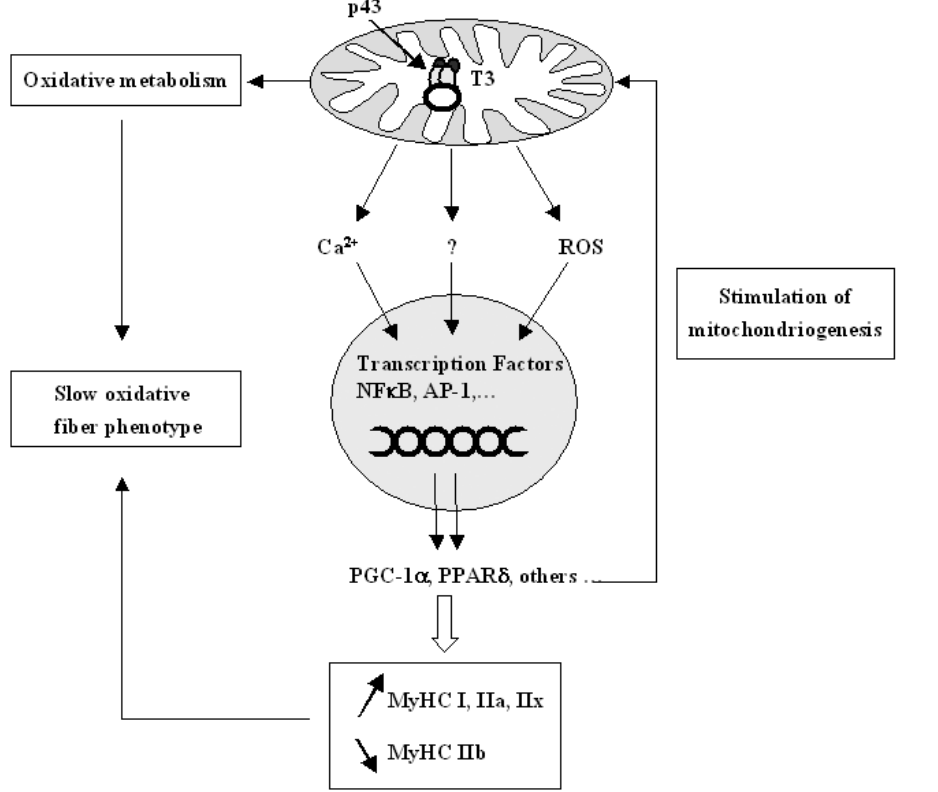
Figure 7. A positive regulatory loop between mitochondrial activity and nuclear genes such as PGC-1 a and PPAR d could be able to coordinate the increase in oxidative metabolism and the expression of slower myosin isoforms. A stimulation of mitochondrial activity induced by p43, could modulate Ca 2 + signalling and mitochondrial reactive oxygen species production, which are well known for altering the activity of some transcriptional factors such as NF k B and AP-1. In this way mitochondrial activity could affect nuclear gene expression of proteins such as PGC-1 a and PPAR d which are involved in muscle specification and in the regulation of mitochondrial biogenesis. This positive regulatory loop could be deeply involved in the determination of muscle metabolic and contractile